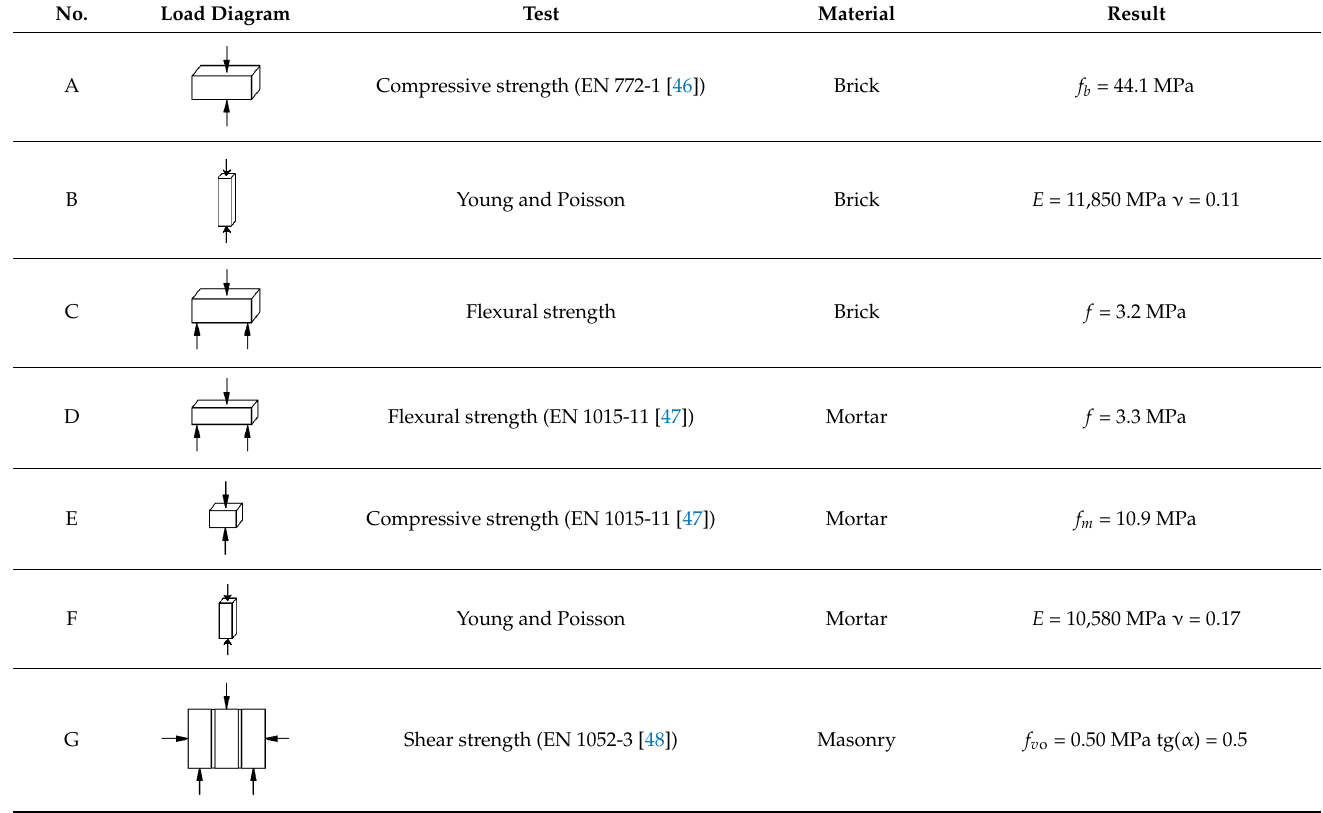
Figure 3. Strut model for the masonry infill wall based on [6] L, H, H 1 , H 2 , H 3 —wall geometry, 1—infill wall; 2—equivalent pinned strut; 3—stress distribution in the equivalent pinned strut; 4—contact stresses at corners; w —width of the strut; L d —length of the strut; f m –compressive strength of the masonry. Table 1. Initial material test results.